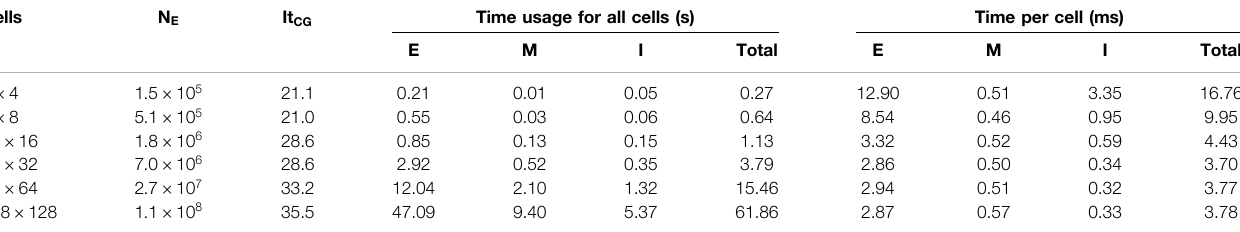
TABLE 7 | Time required to solve a time step of size Δ t (cid:2) 0 . 02 ms for geometries ranging from 4 × 4 cells to 128 × 128 cells using System B (see Section 4.4 ). Cells N E It CG Time usage for all cells (s) Time per cell (ms)